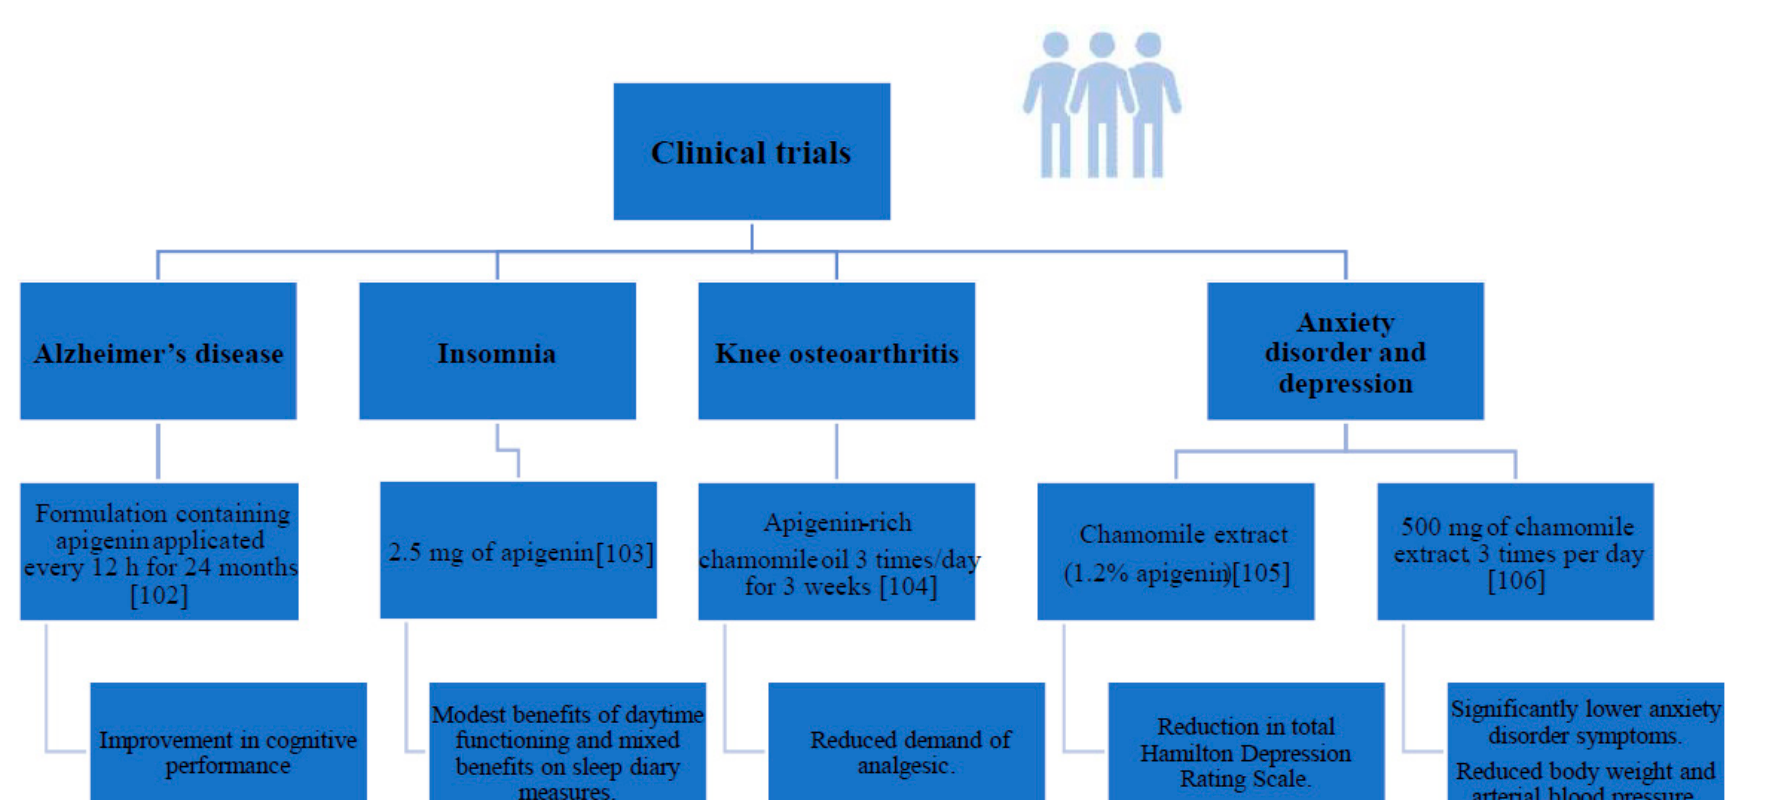
Figure 5. Human studies monitoring apigenin supplementation [102–106].